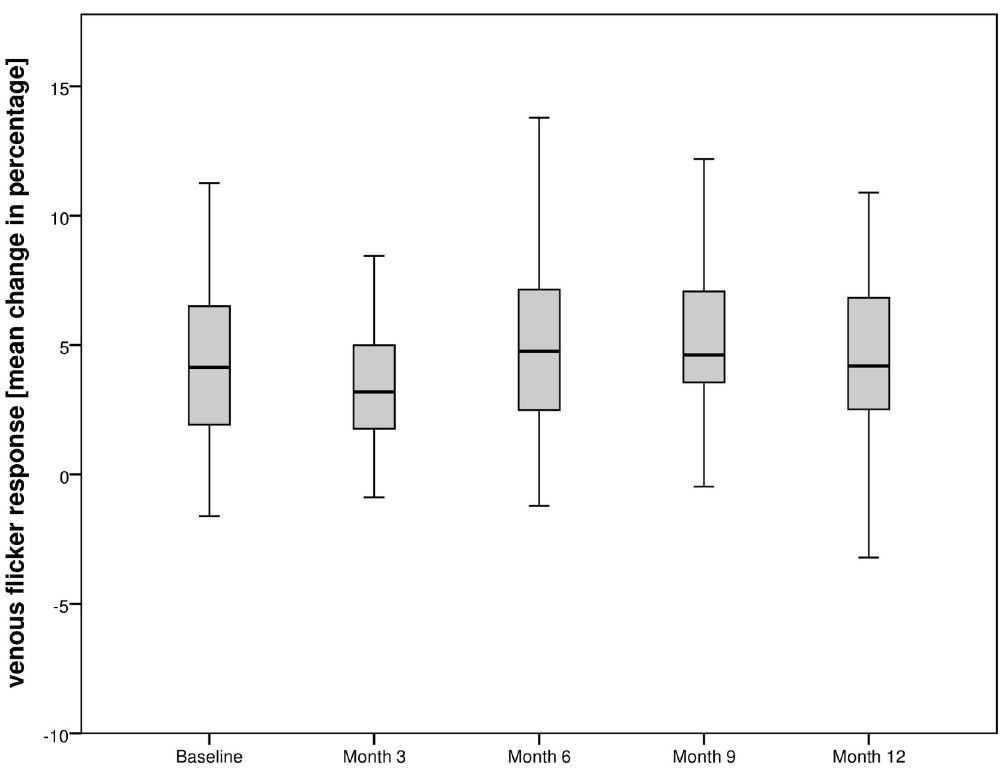
Fig 5. Course of venous flicker response of the total population undergoing intravitreal aflibercept injections over the observational period.